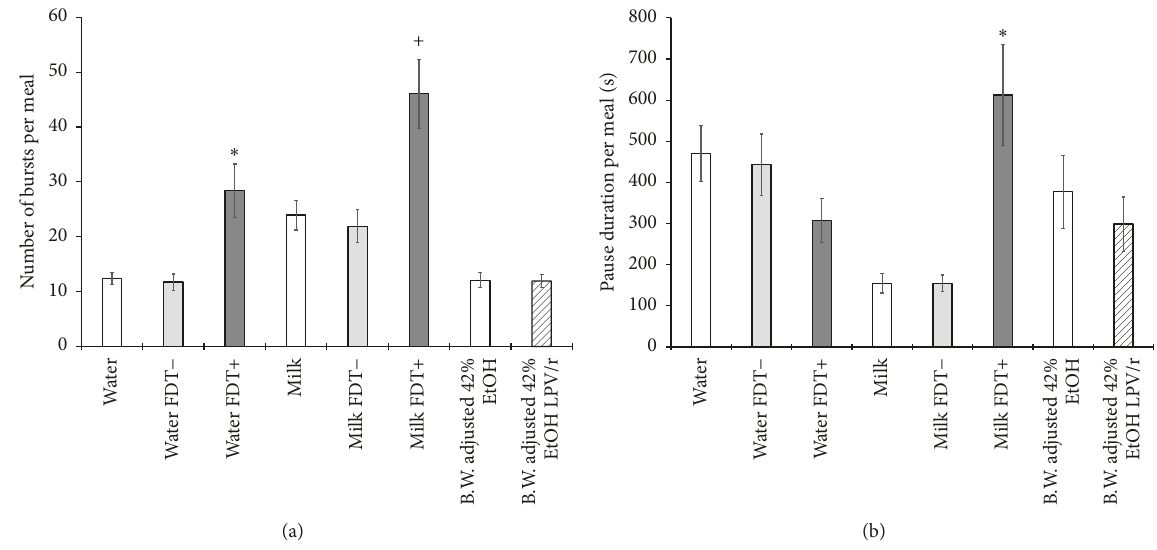
Figure 5: Analyses of licking patterns within meals with bars representing means and SEM error bars. (a) The average number of licking bursts defined by a pause ≥ 1 second. Star ( 𝑝 < .01 ) and plus ( 𝑝 < .05 ) symbols represent significant increases in bursts of licking for FDT+. (b) Cumulative time spent not licking during a meal. The star ( 𝑝 < .01 ) represents a significant increase in time spent paused for FDT+ in